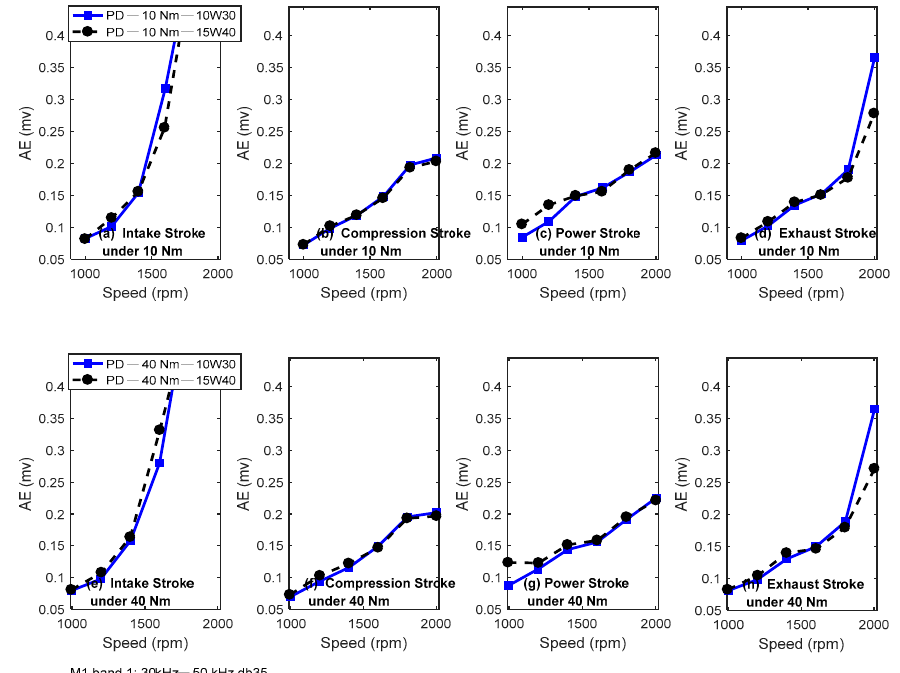
Figure 10. AE indicators from 30 kHz to 50 kHz for four strokes under different operating conditions.